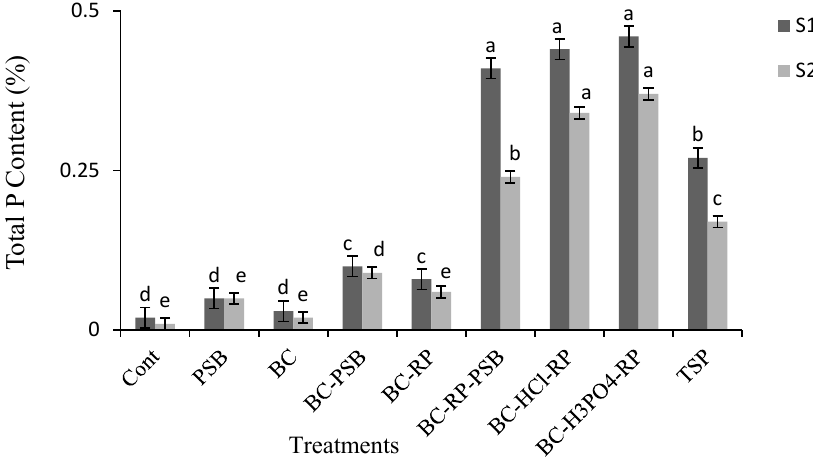
Figure 4. Effect of different treatments on total P content of wheat. PSB: phosphate solubilizing bacteria, BC: biochar, BC-PSB: biochar with phosphate solubilizing bacteria, BC-PSB-RP: biochar Figure 4. E ff ect of di ff erent treatments on total P content of wheat. PSB: phosphate solubilizing bac- enriched with PSB and RP, BC-HCl-PSB: biochar enriched with HCl -RP, BC-H 3 PO 4 -RP: biochar enriched with H 3 PO 4 -RP, TSP: triple super phosphate, Cont: control. Means with similar letters are not significantly different at 1% probability level according to LSD test. Error bars are standard deviation of the means ( n = 3), S1 and S2: soil 1 with EC = 2 dS.m − 1 and soil 2 with EC = 15 dS.m − 1 ,